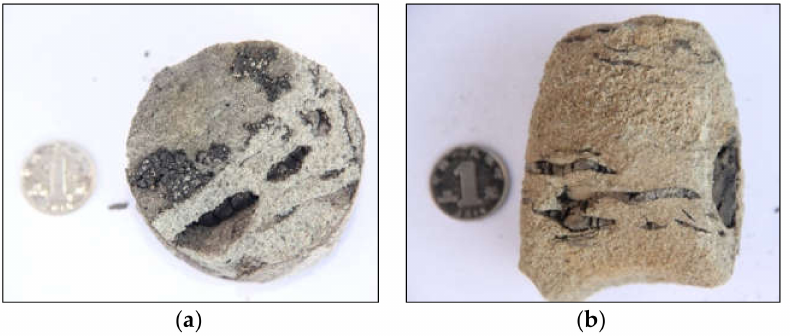
Figure 5. ( a ) Core lithology at the depth of 456.40 m of borehole ZKC252-87; ( b ) Core lithology at the depth of 494.07 m of the borehole